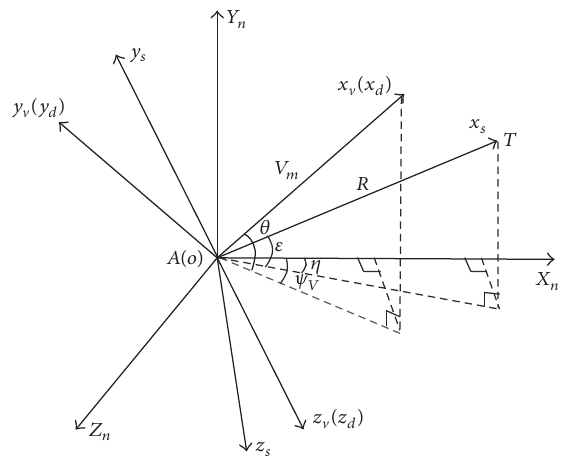
Figure 1: Three-dimensional interceptor-target engagement geom-